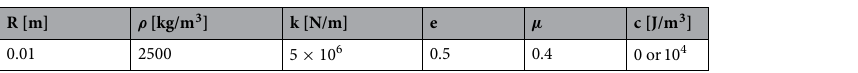
Table 1. Properties of type A grains: radius R , density ρ , elastic stiffness k , coefficient of restitution e , coefficient of friction µ and cohesion c . Type B grains feature a difference in one these parameters. Grains are not cohesive ( c = 0 ) in all tests except for those presented in Fig.